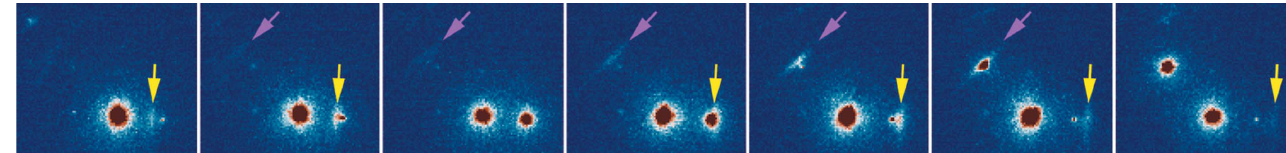
Figure 2 Seven consecutive frames from the Si cRED data set, showing Kikuchi lines as diffuse contrast passing through Bragg spots, marked by magenta and yellow arrows.